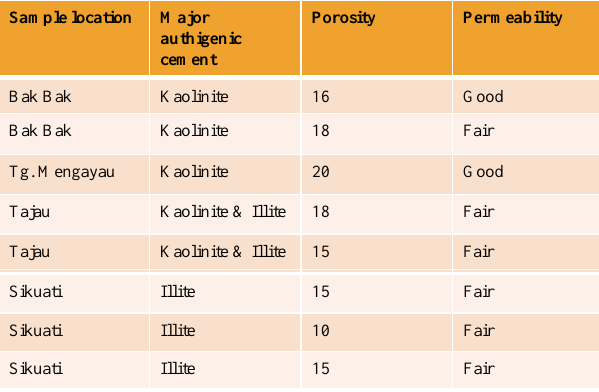
Permeability result from the analyzed sandstone